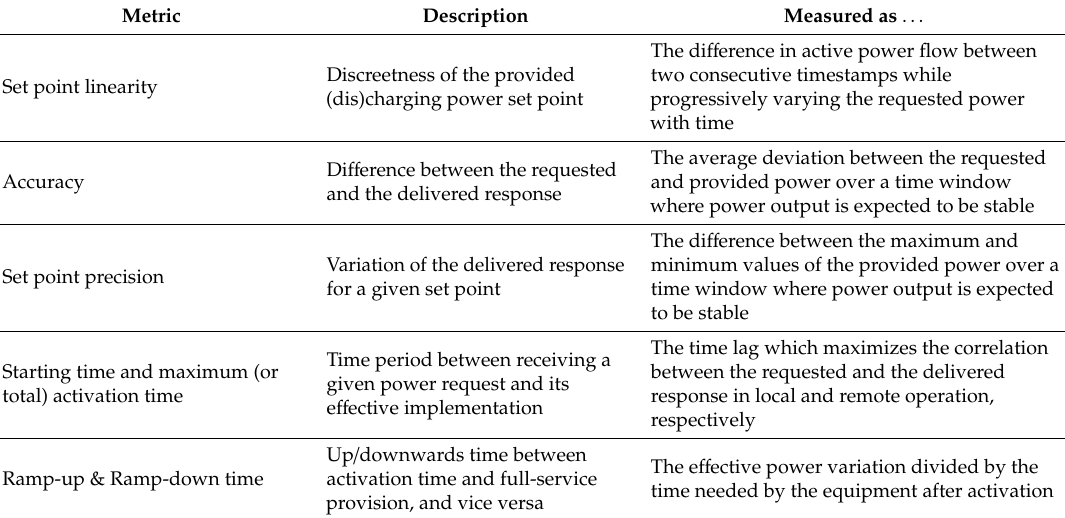
Table 1. Assessment metrics for vehicle-to-grid (V2G) systems as proposed in [14]. The presented information is derived from Table 2 in said reference, as well as from other sections of the